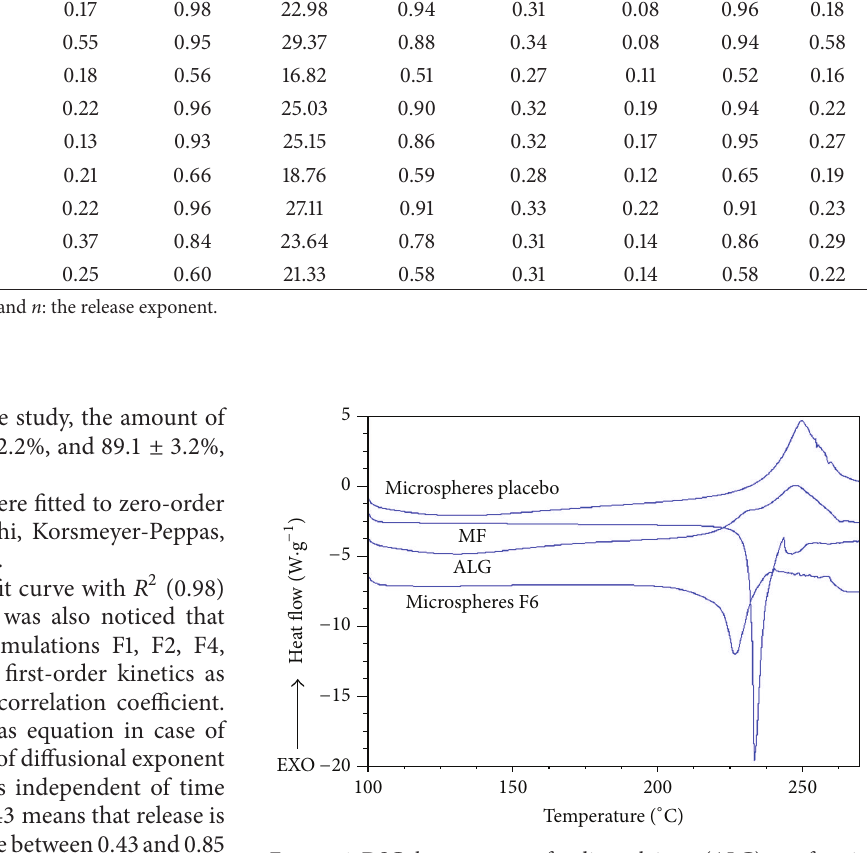
Figure 4: DSC thermograms of sodium alginate (ALG), metformin hydrochloride (MF), microspheres placebo, and microspheres for- mulation